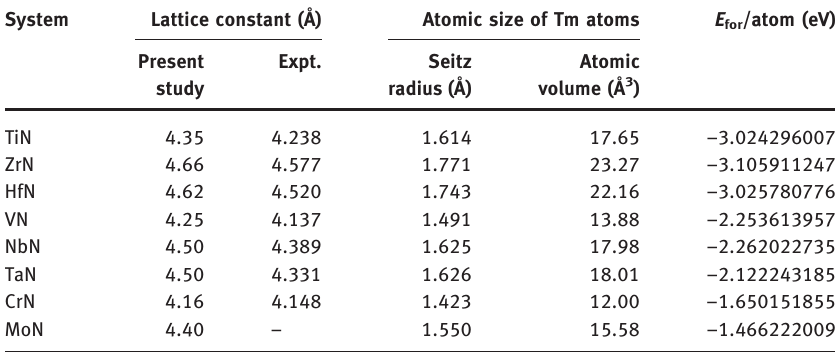
Table 2: Equilibrium lattice constants and formation energy/atom of metal nitrides TmN (Tm ¼ Ti, Zr, Hf, V, Nb, Ta, Cr, Mo) and corresponding atomic size and volume of Tm metals. System Lattice constant (Å) Atomic size of Tm atoms E for /atom (eV) Present Expt. Atomic study radius (Å)